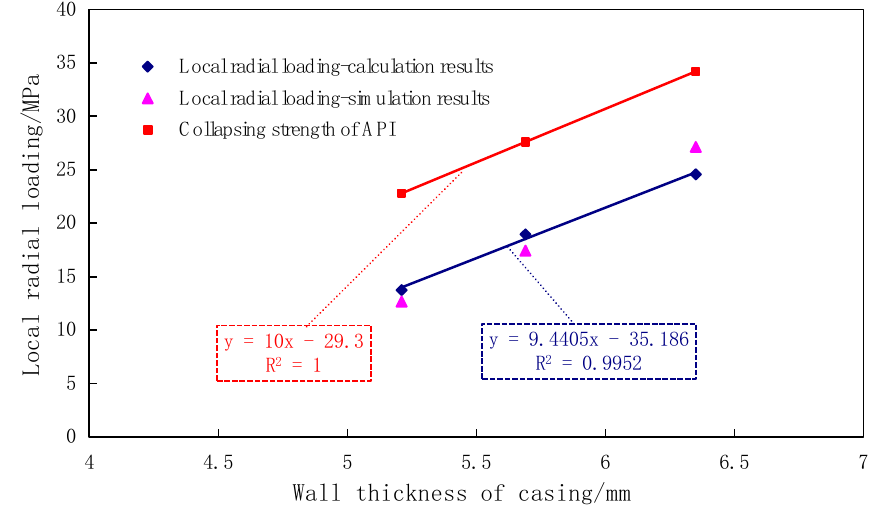
ff erent wall thicknesses of 4 1